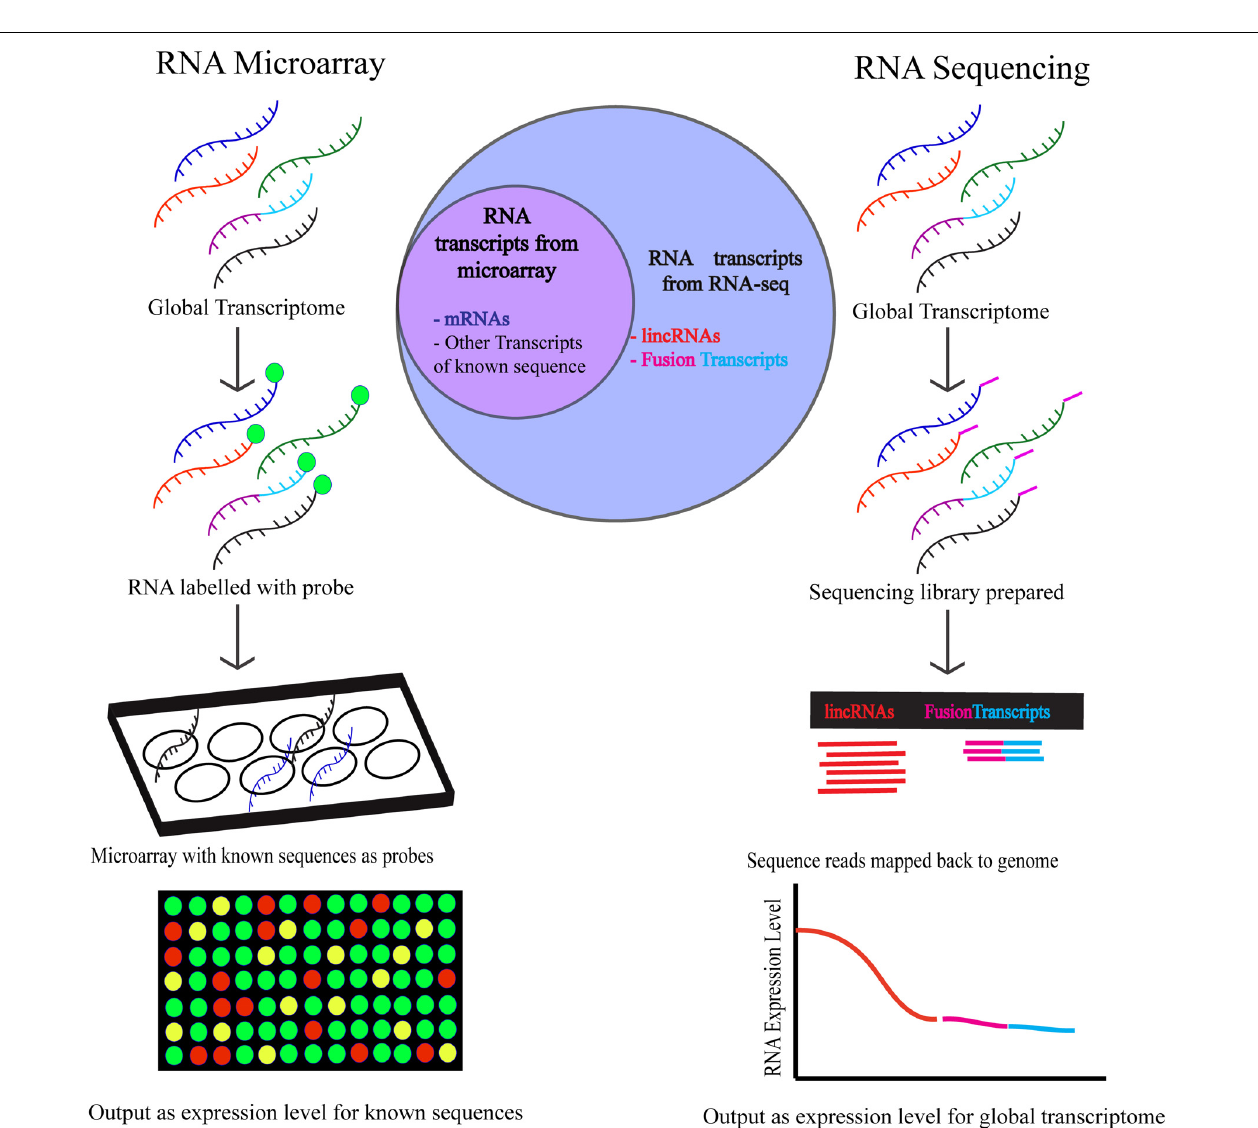
FIGURE 2 | The workflow of RNA-microarray and RNA-sequencing is depicted above. Higher number of targets are detected by RNA-sequencing using which targets of unknown sequence and low abundance targets can both be identified. To detect targets using RNA microarrays, the sequence of the transcripts must be known and expressed in abundance in the